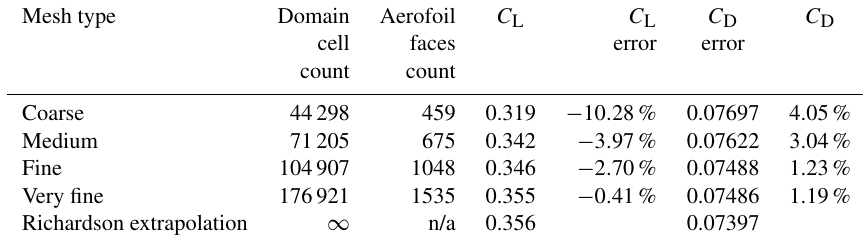
Table 1. Grid independence study for the scanned blade without spoiler at α = 0 ◦ and Re c = 3 × 10 6 . Mesh type